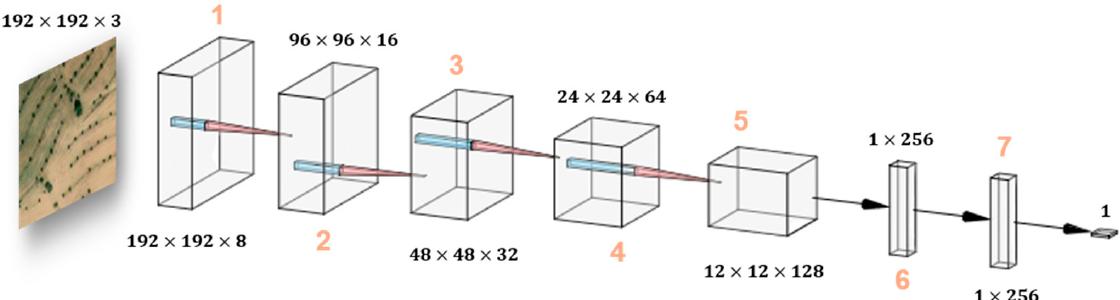
Figure 7. CNN architecture (taking DG patches as input). Each convolution block contains two 3 × 3 BN-Conv-LR sequences. A 2 × 2 max pooling is used between any two of the convolutional blocks. A global average pooling is added between component 5 and 6. Two fully connected layers and one sigmoid layer are followed after convolutional layers.